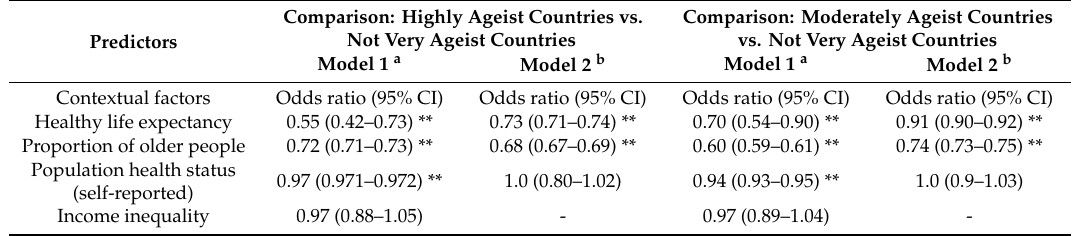
Table 2. Multinomial logistic regression results: influence of contextual factors on Level 2 latent class membership. Comparison: Highly Ageist Countries vs. Comparison: Moderately Ageist Countries Not Very Ageist Countries vs. Not Very Ageist Predictors